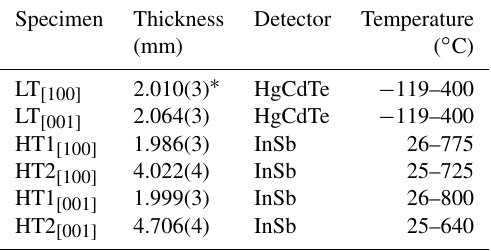
∗ Numbers in parentheses are 1 σ standard deviation of the last